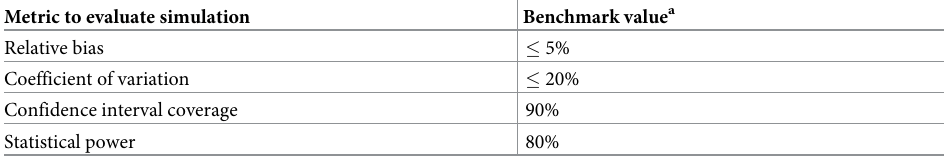
Table 2. Metrics and associated benchmark values used to evaluate simulations of territory-occupancy monitor- ing for ferruginous